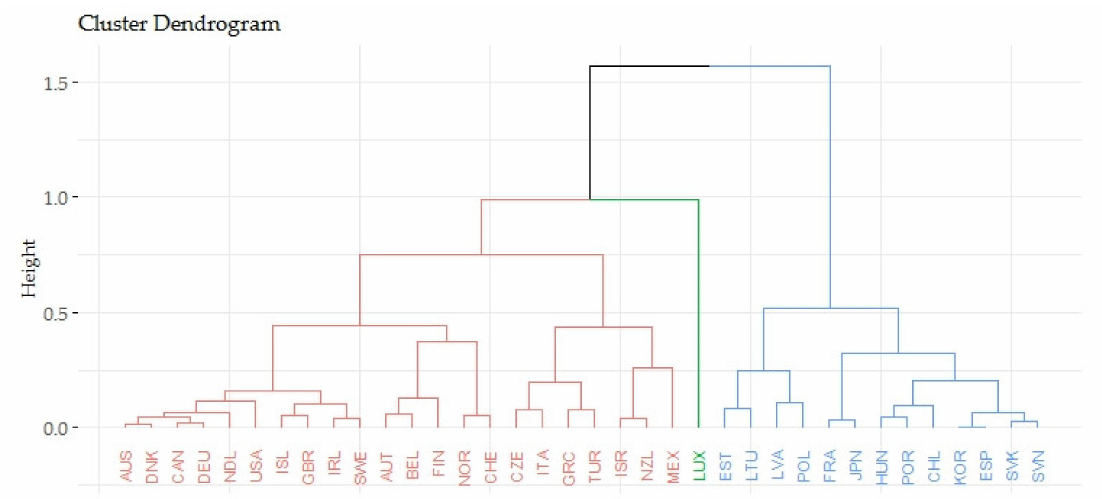
Figure 1. Hierarchical clusters of OECD countries—the relations of economic prosperity and gender inequalities in life